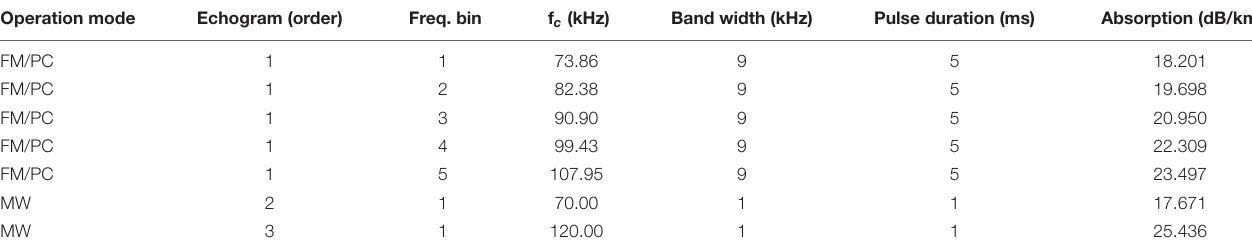
TABLE 2 | Signature100 operational settings used during the 2018–2019 Antarctic summer deployment. Operation